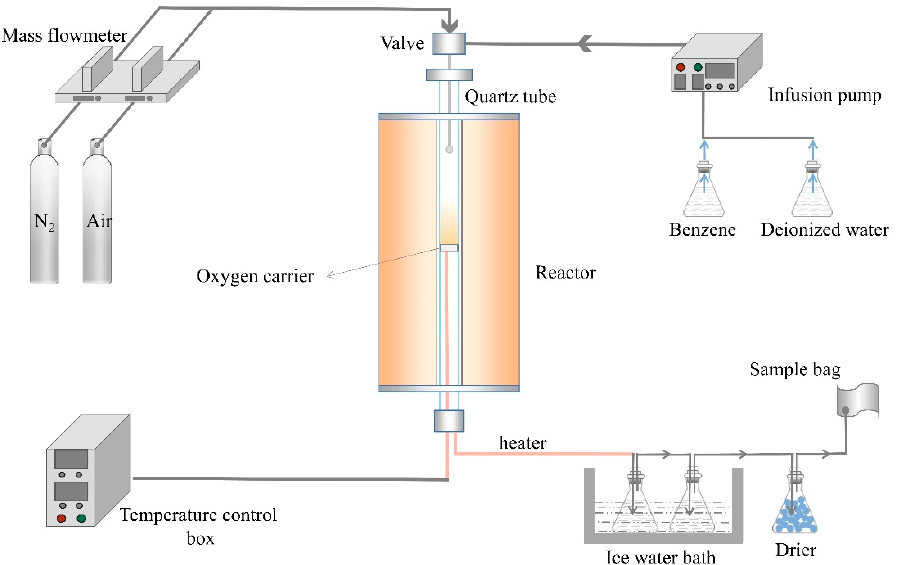
Figure 9. A schematic of the fixed bed experiment.